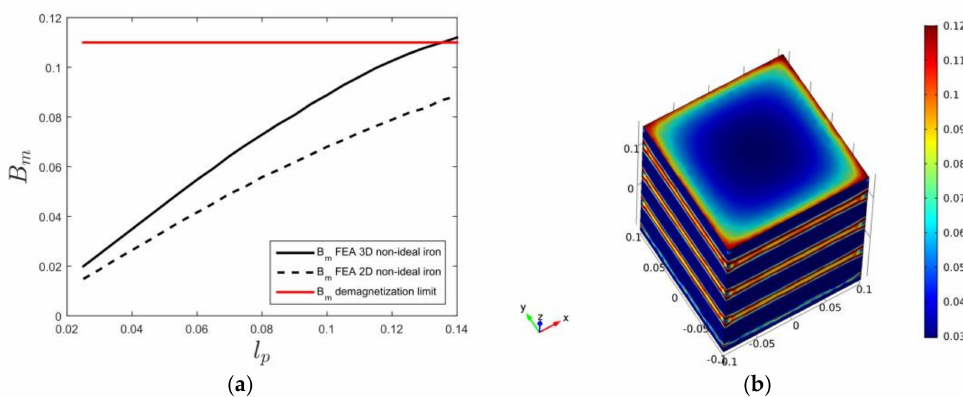
Figure 6. The B z component is calculated for a step in the in the mounting process of a square translator block of Y40 ferrite magnets and iron parts, where a layer of magnets is on the top surface. Results from 2D and three-dimensional (3D) simulations at the center of the top surface of the top magnet for different pole lengths is given in ( a ) and ( b ) shows the special case of 35 mm pole length in 3D. Calculations are made using the parameters k = 0.45, w T = 0.2 m, and µ r,m = 1.1. The 3D simulations assume a stacking width l s = 0.2 m, which improves the demagnetization situation for the